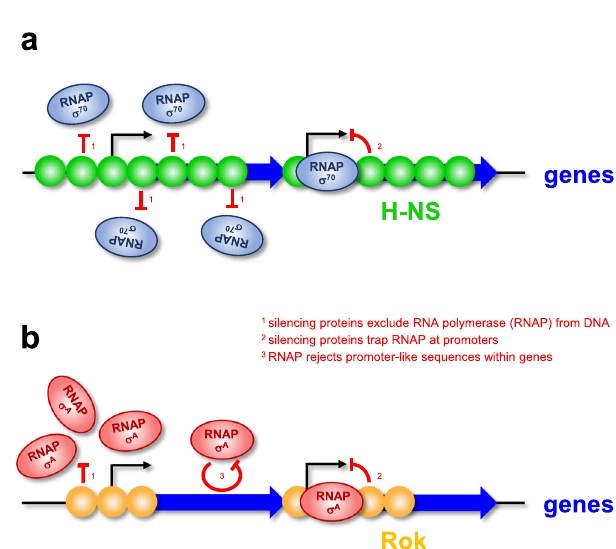
Fig. 6 Different xenogeneic silencing strategies in E. coli and B. subtilis . a In E. coli , H-NS (green) binds to extensive tracts of DNA. Consequently, the comparatively promiscuous E. coli housekeeping RNA polymerase (blue ovals) is prevented from synthesising mRNAs, and many spurious intragenic RNAs, from sections of AT-rich horizontally acquired DNA (blue block arrows). H-NS may repress transcription by blocking access of RNA polymerase to the DNA and by trapping RNA polymerase at promoters (bent arrows). b In B. subtilis , Rok (orange) binds to shorter tracts of DNA around promoters (bent arrows) at gene 5 ′ ends. This stops the synthesis of mRNAs from sections of AT-rich horizontally acquired DNA (blue block arrows). The less promiscuous housekeeping RNA polymerase of B. subtilis containing σ A (red ovals) is not prone to spurious intragenic transcription initiation. Trapping of RNA polymerase early during elongation appears